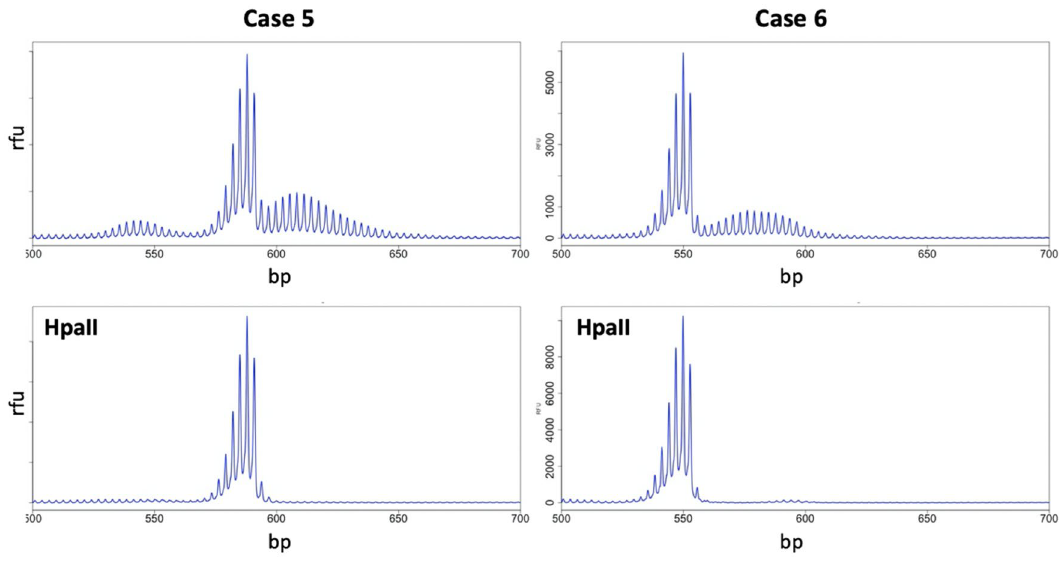
Figure 3. Expansion is limited to PM alleles on the active X chromosome. PCR profiles of two PM female carriers without (top panels) and with (bottom panels) HpaII digestion show the loss of the larger of the two allele populations on predigestion of the template with HpaII which preferentially eliminates alleles on the active X chromosome.